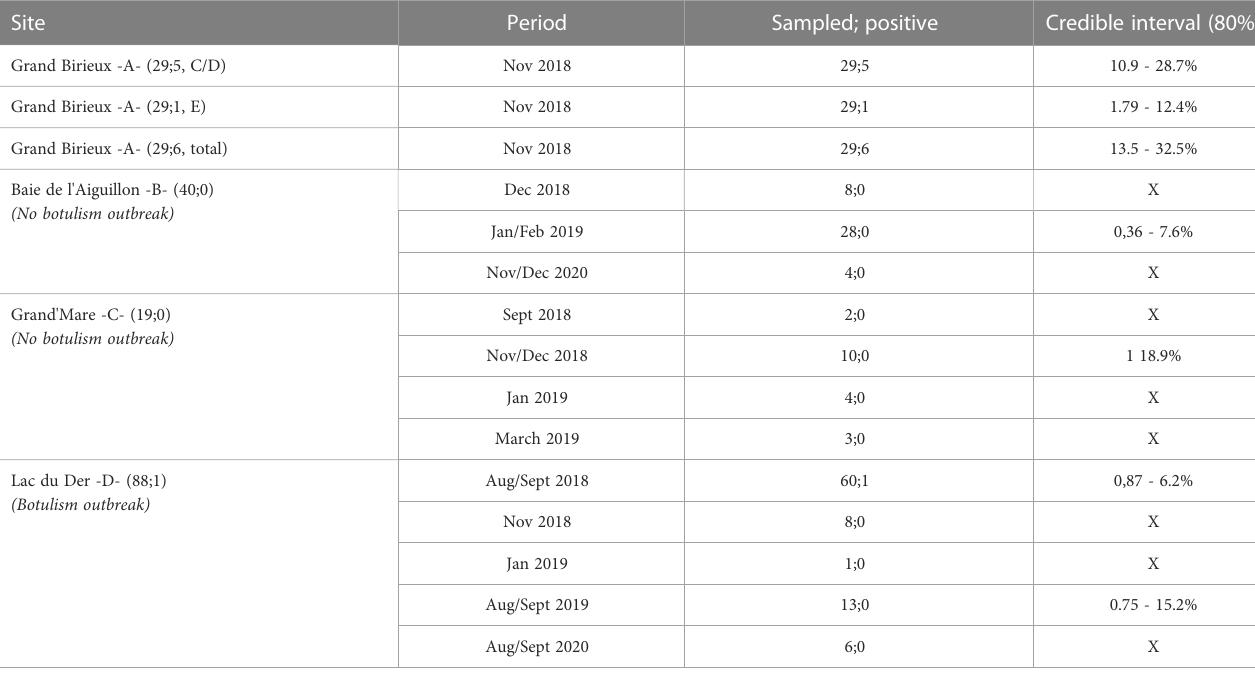
TABLE 2 Credible interval (80%) on prevalence of positive swabbed banded birds in Baie de l ’ Aiguillon (B), Grand ’ Mare (C) and Lac du Der (D) and of positive ceca of hunted birds in Grand Birieux (A). Site